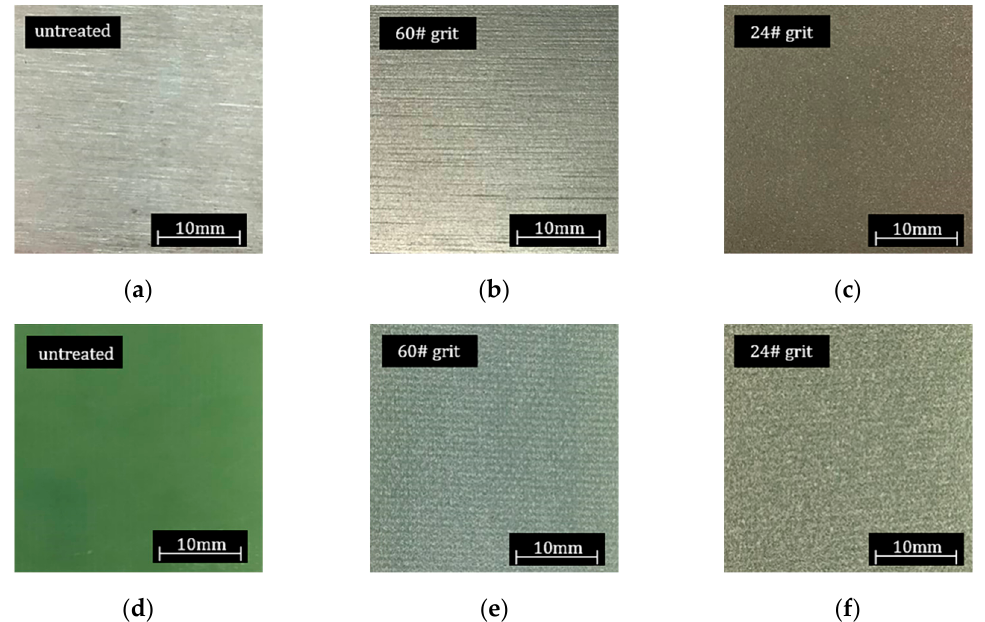
Figure 2. Plate surfaces with and without grit-blasting treatment. ( a ) Untreated stainless-steel surface; ( b ) stainless-steel surface treated with 60# grit-blasting ; ( c ) stainless-steel surface treated with 24# grit-blasting ; ( d ) untreated GFRP surface; ( e ) GFRP surface treated with 60# grit-blasting ; ( f ) GFRP surface treated with 24# grit-blasting.